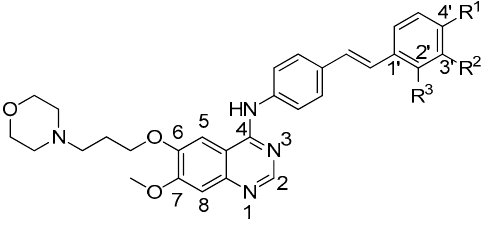
Figure 1. Chemical structures of 4-anilinoquinazoline derivatives 6a – 6j .